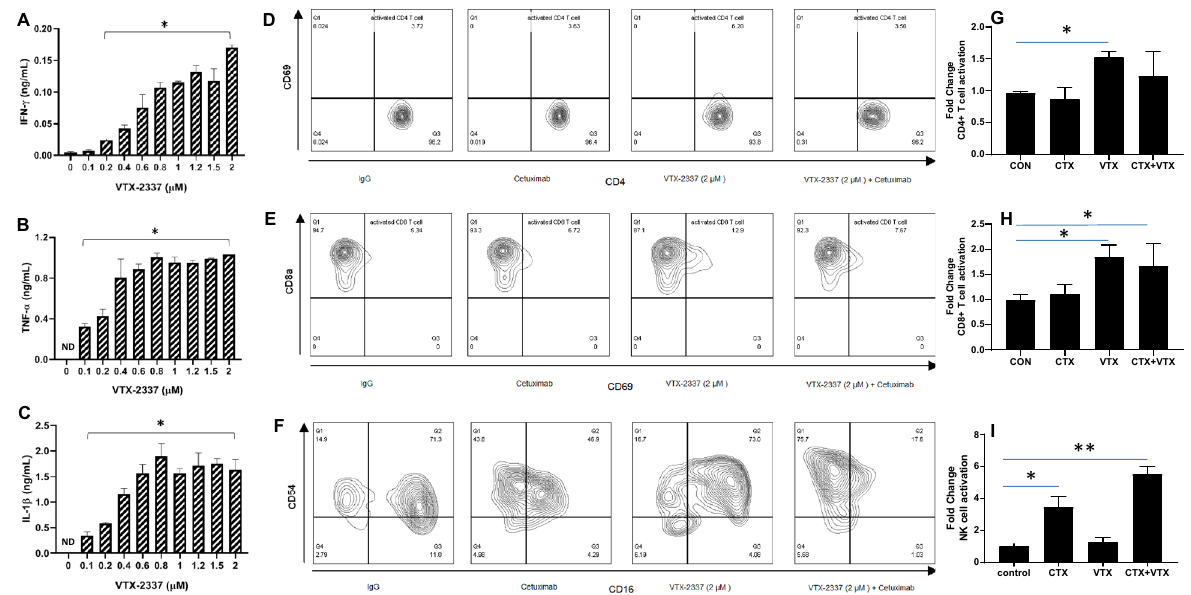
Figure 3. A TLR8 agonist stimulates immune cell activity. ( A – C ) Peripheral blood mononuclear cells (PBMCs) were treated with serial dilutions of VTX-2337 for 24 h, then cell culture media harvested for analysis of IFN-γ ( A ), TNFα ( B ) and IL-1β ( C ) by ELISA. *p < 0.01 versus 0 µM. ( D – I ) SQ20B cells were co-cultured with PBMCs, treated with VTX and/or cetuximab (CTX) for 24 h, then activated CD4 + ( D , G ), CD8 + ( E , H ), and NK cells ( F , I ) analyzed by flow cytometry. Human IgG 1 was used as a control (CON). Bar graphs shown in ( G – I ) represent the mean of n = 3 experiments. Error bars represent standard deviation from the mean. *p < 0.05 versus CON, **p < 0.01 versus CON (One-way ANOVA, Tukey’s multiple comparison